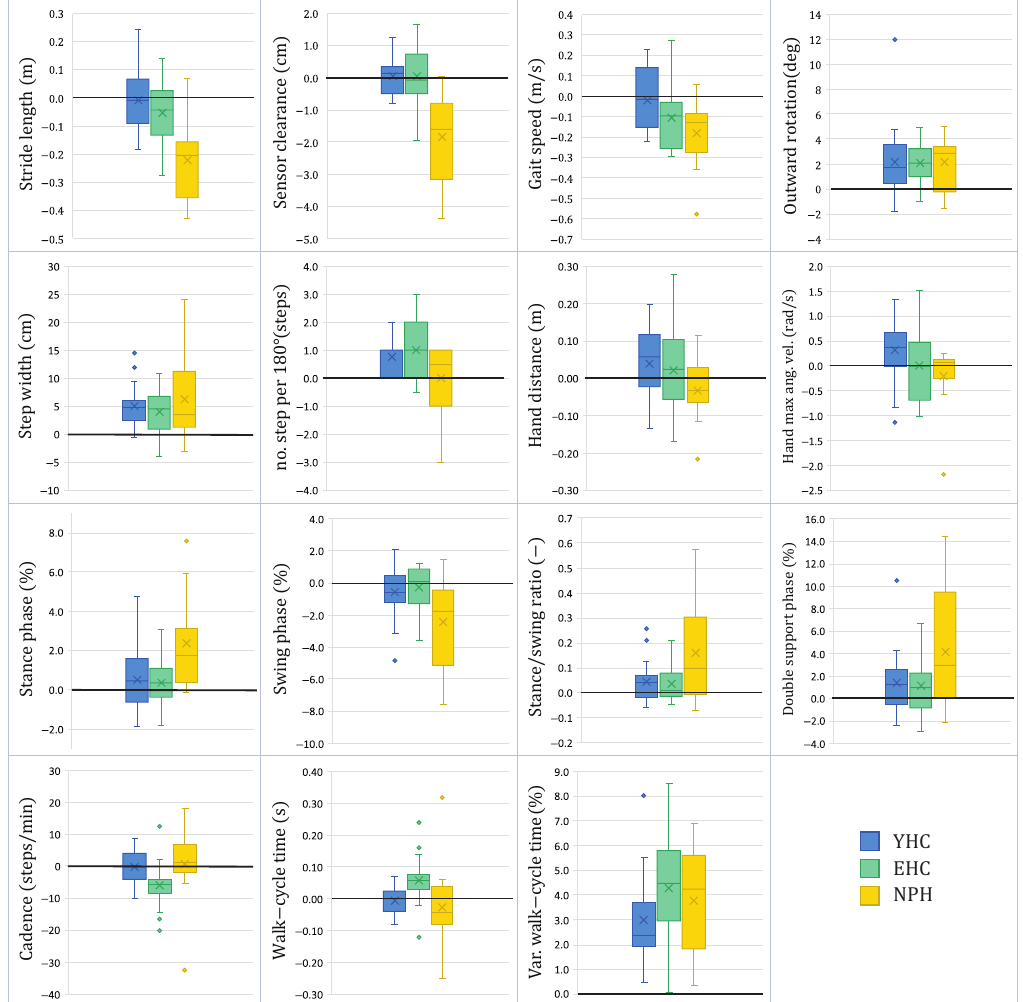
Figure 3. The boxplots illustrate the comparison between controlled and real-world environments for 20 young healthy control (YHC), 20 elderly healthy control (EHC) and 12 normal pressure hydrocephalus patients (NPH). Each plot indicates the absolute difference between the parameter’s median values in each scenario of every subject − Parameter subject (Parameter subject ). Within each box-plot, the group’s median and mean values are indicated as a line real − world lab and a cross, respectively, and outliers are indicated as dots. The upper and lower edges of the box span the interquartile range, and whiskers indicate the most extreme data points not considered